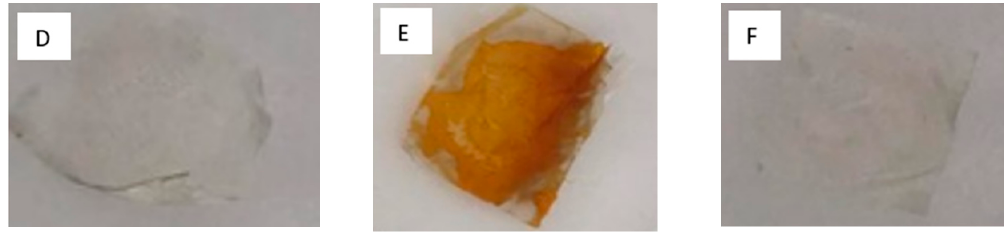
Figure 3. Images of films based on sodium alginate in ( A ) HCl, ( B ) NaOH and ( C ) water and 70SA/30TA in ( D ) HCl, ( E ) NaOH and ( F ) water.